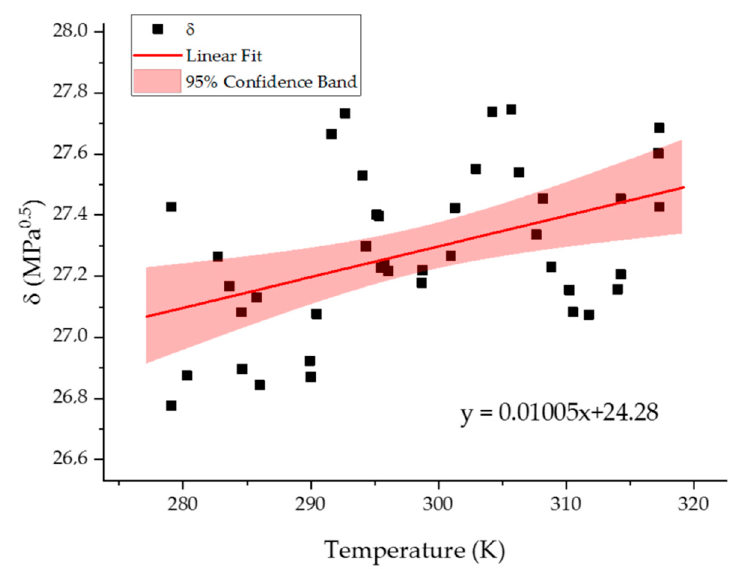
Figure 6. The dependence of Hansen solubility parameter on temperature. The value of the slope of linear correlation (red line) is 0.01005 ± 0.0032 MPa 0.5